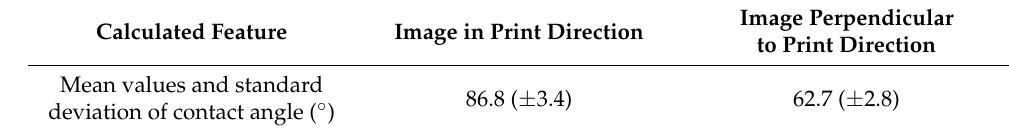
Table 4. Contact angle measurement results for sample—18, PLA object.